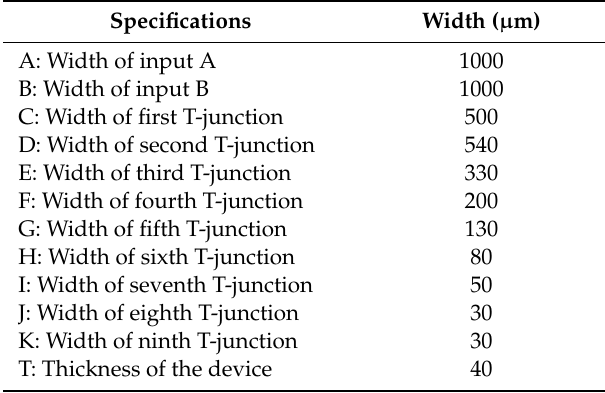
Figure 2. Computer-aided design (CAD) of the 512-channel geometrical passive breakup device. Table 1. Specifications of the 512-channel geometrical passive breakup device.